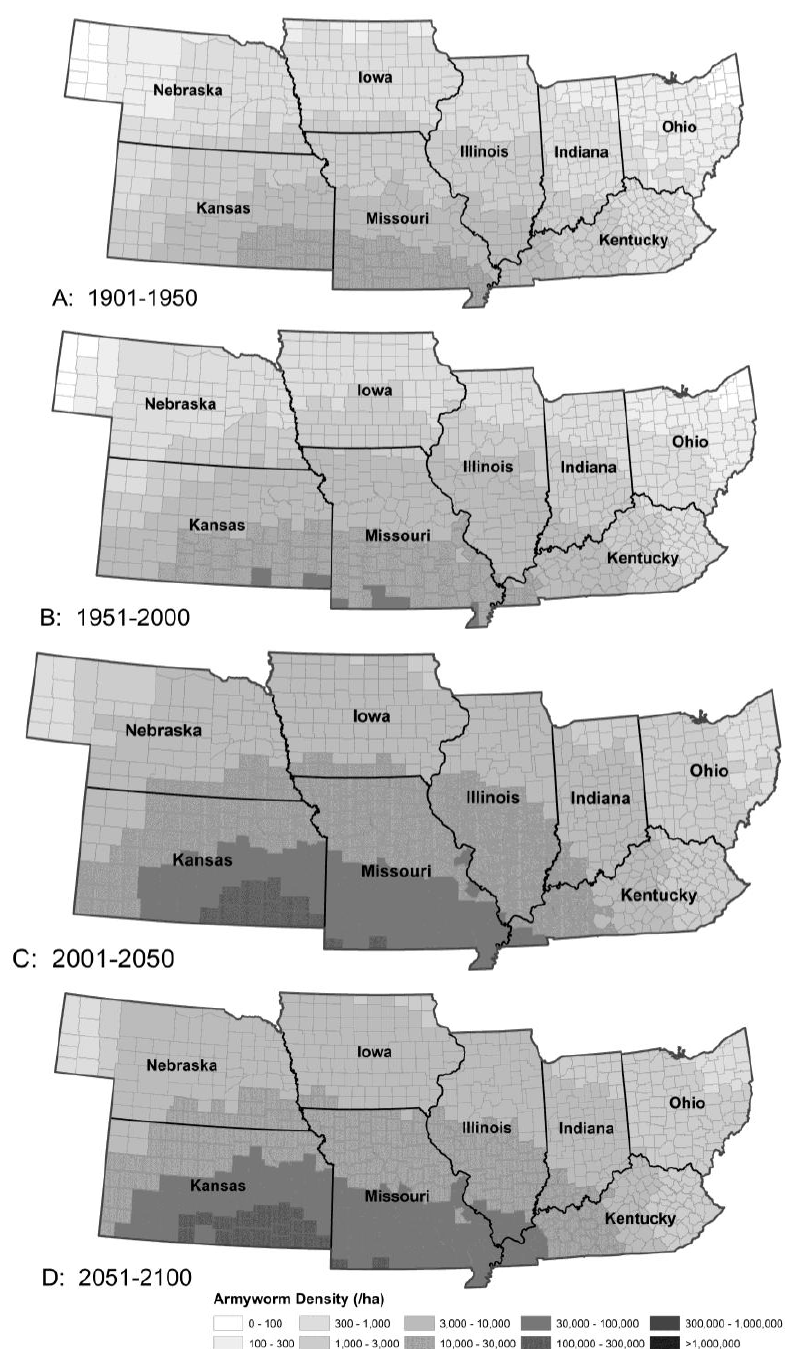
Figure 4. The model predicted essentially no change in armyworm summer abundance from Period 1 ( A ) to Period 2 ( B ), an increase from Period 2 to 3 ( C ) with local changes only in abundance from Period 3 to 4 ( D ). The distribution and trajectory of back cutworm and corn earworm were similar.